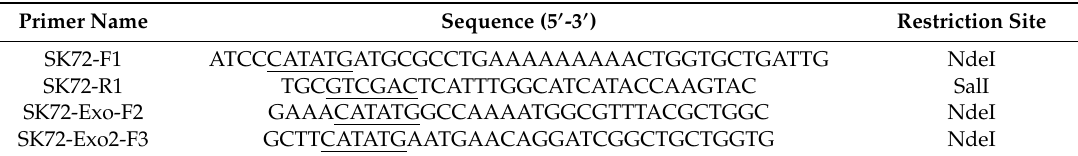
Table 2. List of primers used for subcloning into a pET28 expression